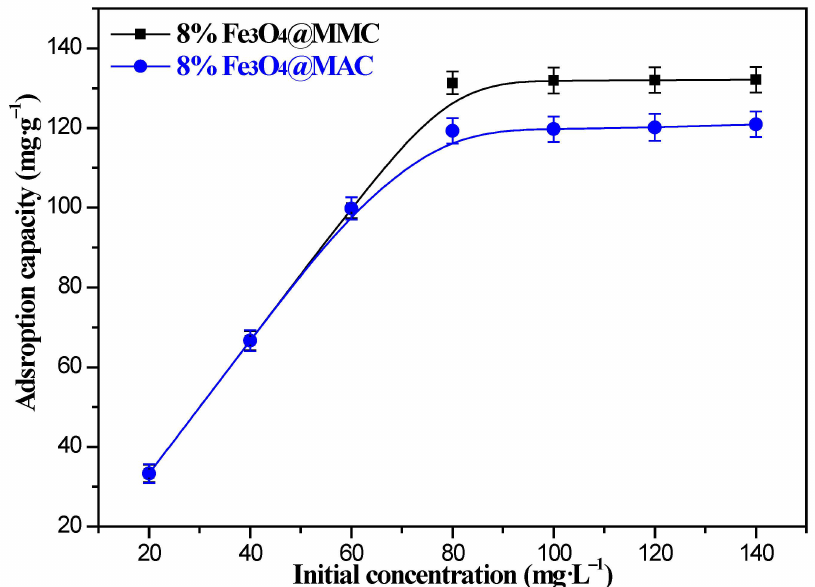
Figure 9. Effect of initial Cr(VI) ions’ concentration on the sorption. Adsorption conditions: volume, 50 mL; pH, 2.0; adsorbent dosage, 0.03 g; temperature, 298 K; adsorption time, 180